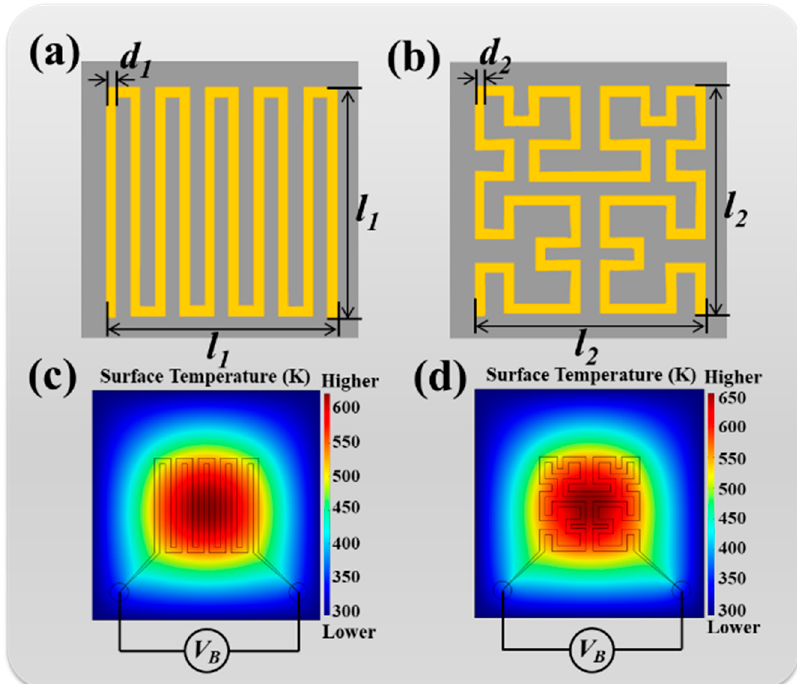
Figure 2. Schematic drawings of ( a ) winding microheater and ( b ) Peano-shaped microheater. ( c , d ) Surface temperature distributions of winding microheater and Peano-shaped microheater, respectively. Geometrical dimensions are kept as d 1 = d 2 = 6.0 µm and l 1 = l 2 = 120 µm.